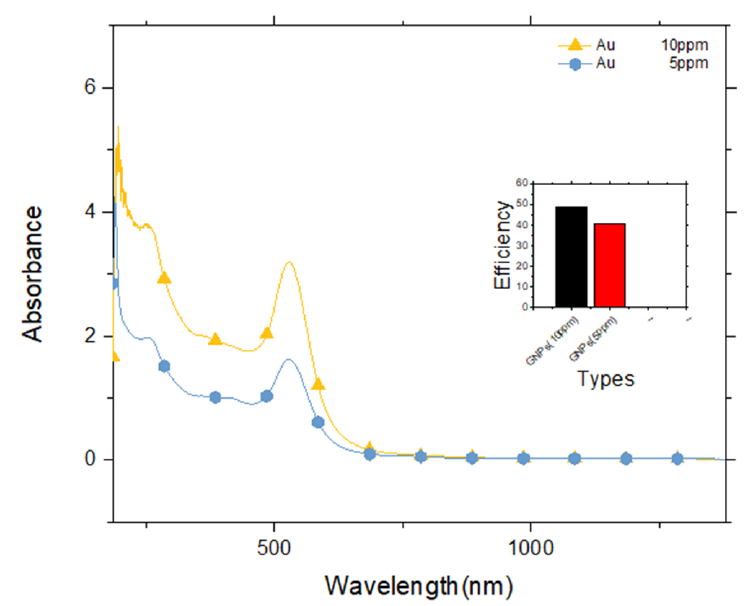
Figure 13. Absorption spectrum and absorptivity of gold nanofluid used in the experiment. From Figure 13, the absorption peak of the gold nanofluid is 520 nm, and the absorp- tion efficiency significantly decreases after 760 nm. Increasing the concentration of the